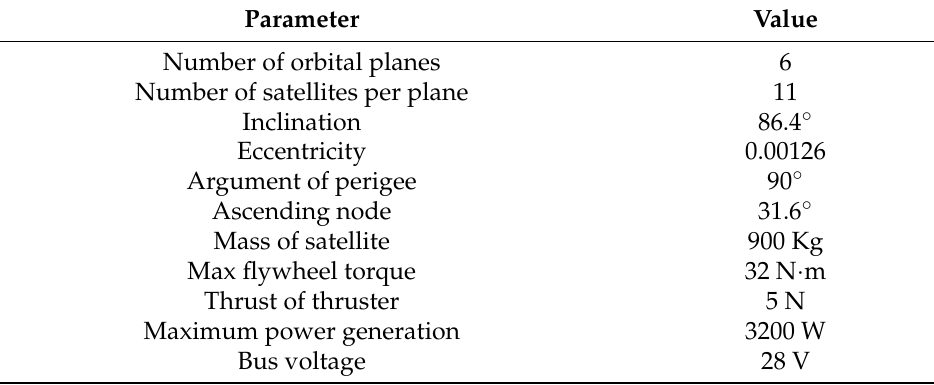
Table 2. Simulation parameters of the satellite constellation